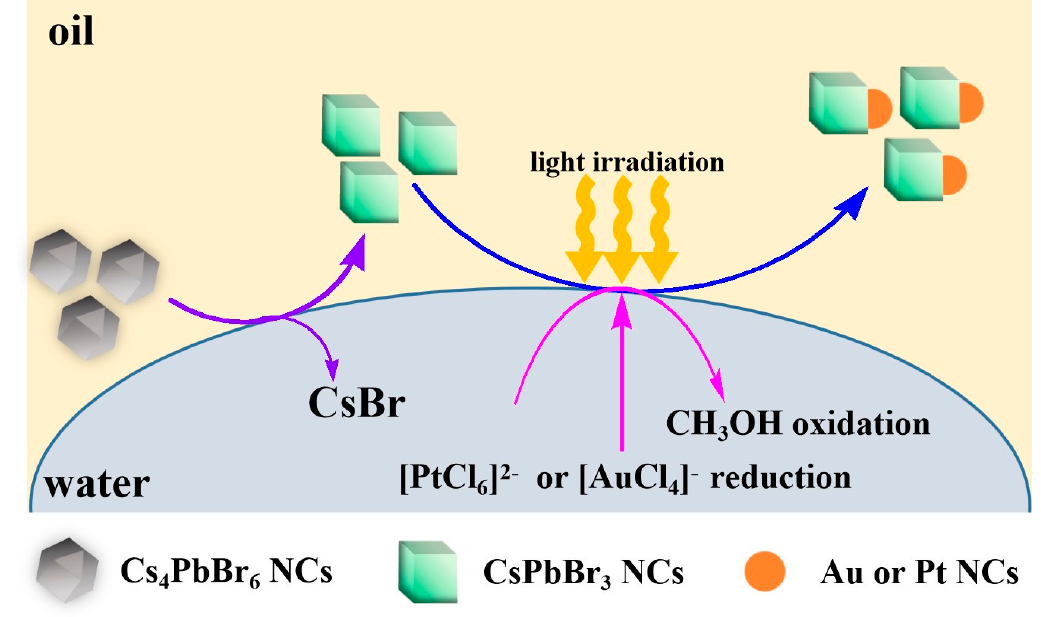
Figure 1. Diagram of transformation of Cs 4 PbBr 6 into Au or Pt@CsPbBr 3 at the water/hexane interface.